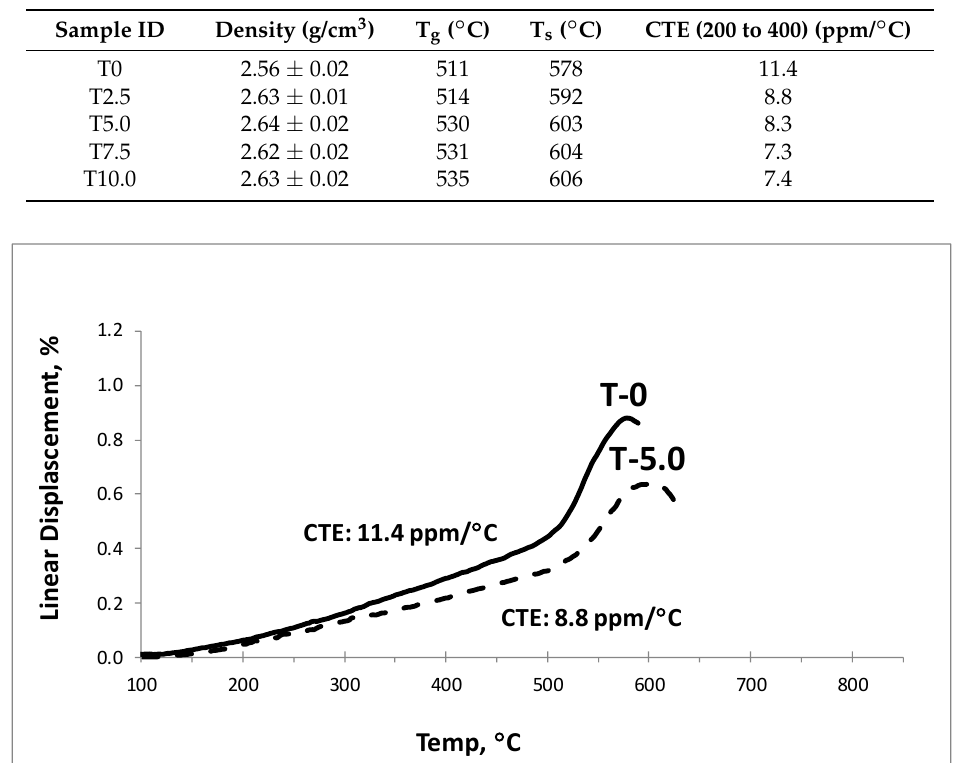
Figure 4. Dilatometric analysis of the T0 and T5.0 glass enamels.